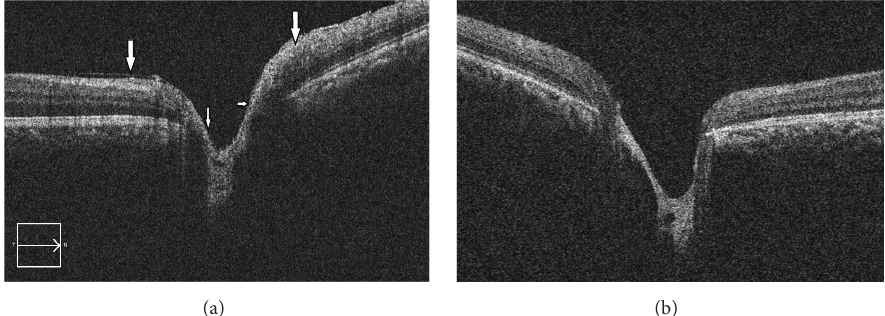
Figure 5: Optical coherence tomography through the optic nerve head showing hyperreflective crystals on the ILM and the inner retinal layers in the right eye ((b) left eye for comparison).